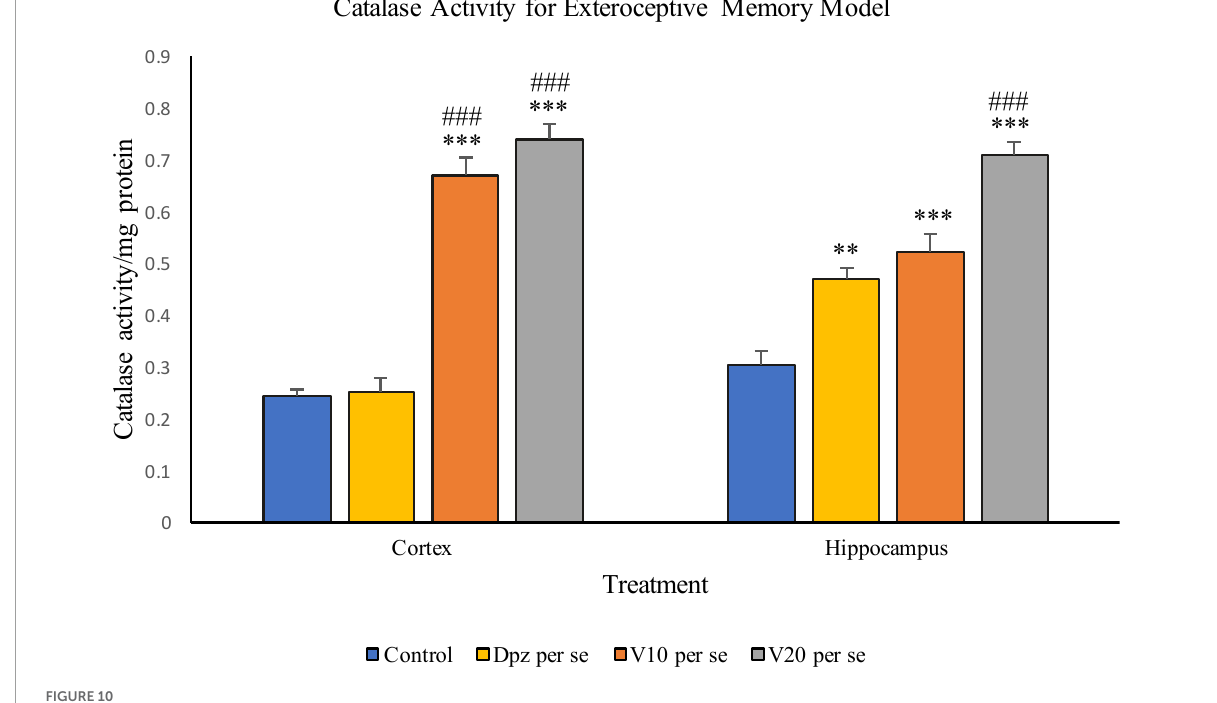
FIGURE10 Effect of vanillin and other treatments on catalase activity. Data are expressed as mean ± SEM. “***” denotes P < 0.001 with respect to the control group, and “**” denotes P < 0.01 with respect to the control group. “###” denotes P < 0.001 with respect to the standard treatment